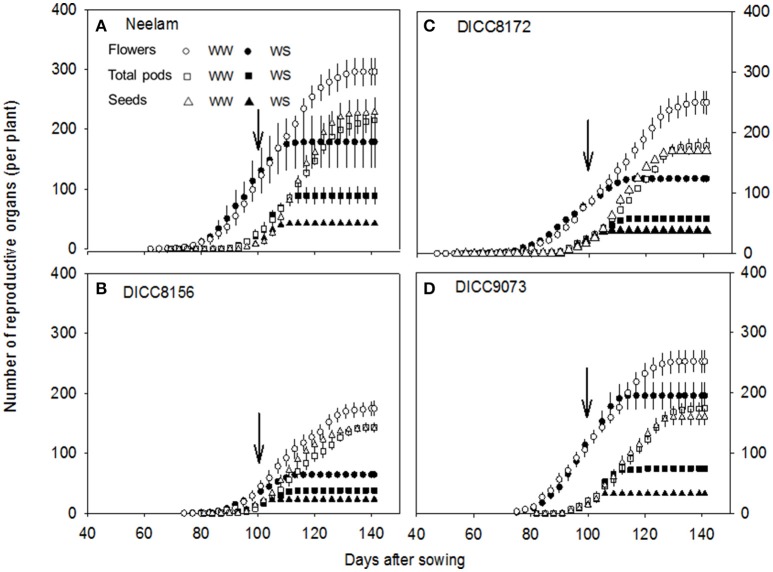
Changes in the cumulative number of flowers, total pods, and seeds per plant with time (days) after sowing in the well-watered (WW) and water-stressed (WS) treatments in four chickpea genotypes: Neelam (A), DICC8156 (B) DICC8172 (C), and DICC9073 (D). Data are means ± s.e.m. (n = 4). Arrows indicate the start of the water treatments. The data for the other six genotypes are in the Figure S3.